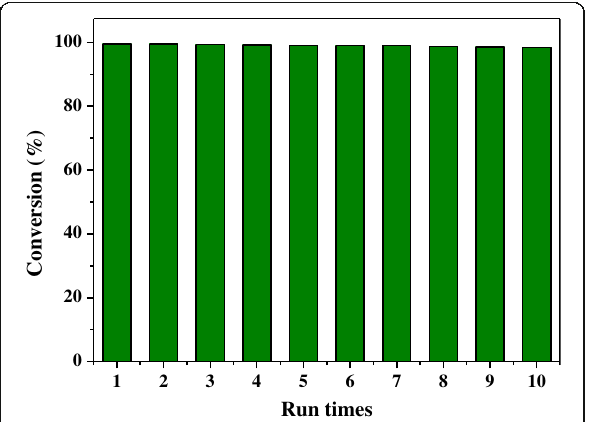
Fig. 6 Recycling tests for the reduction of 4-nitrophenol over the Ag@HPS-1